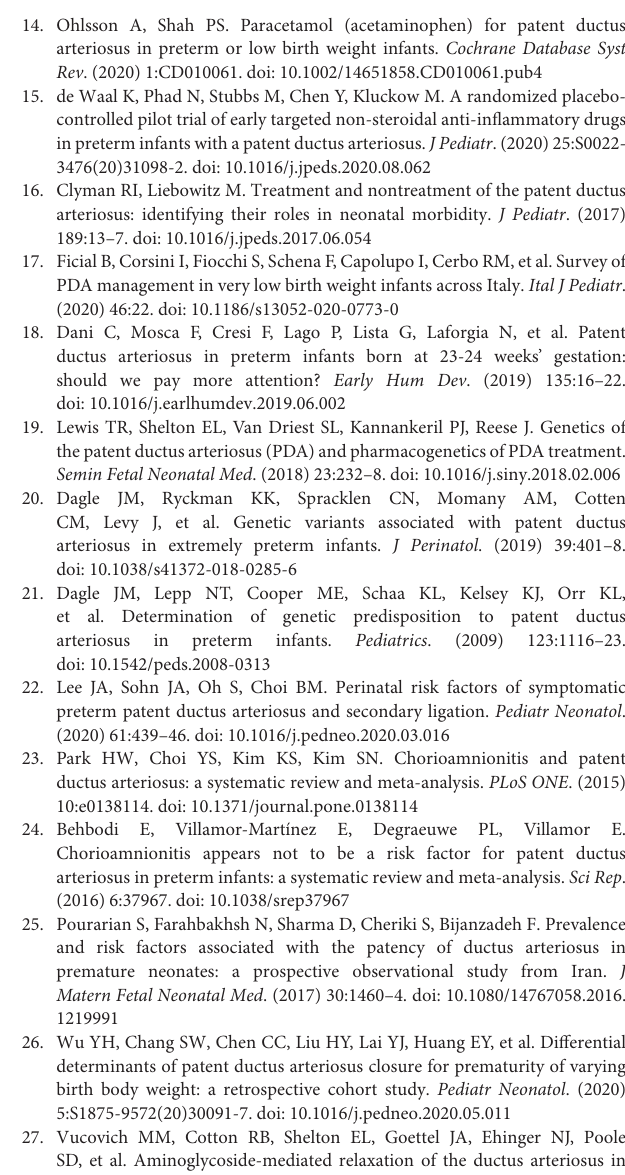
Supplementary Figure 1 | Validation plots of OPLS-DA model ( ≤ 30w No-hsPDA, > 30w No-hsPDA and ≤ 30w hsPDA) using a permutation test. The horizontal axis shows the correlation between the permuted and actual data, while the vertical axis displays the cumulative values of R 2 and Q 2 . The intercept gives an estimate of the overfitting phenomenon.